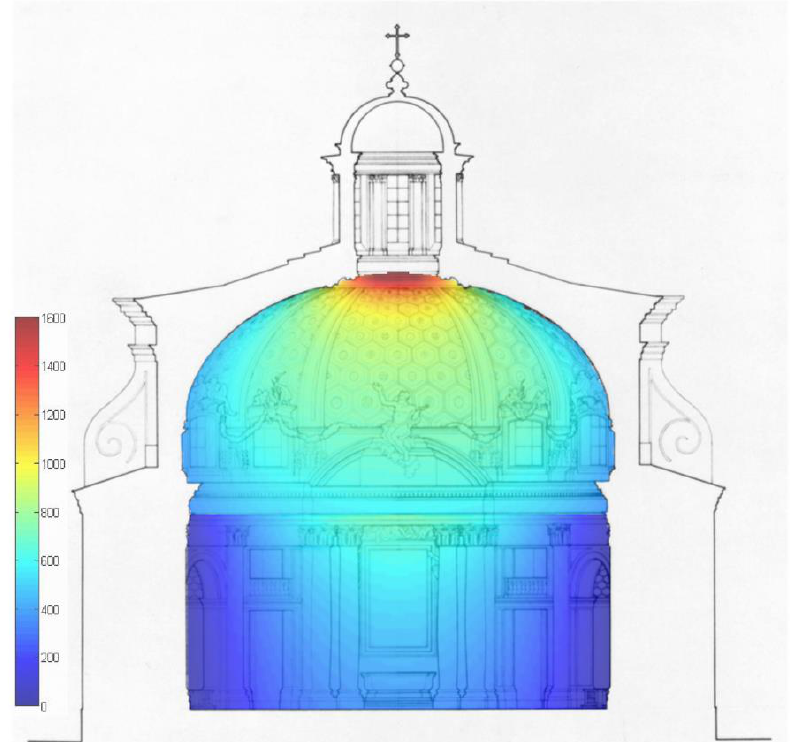
Figure 10. Daylight cross section of the church.